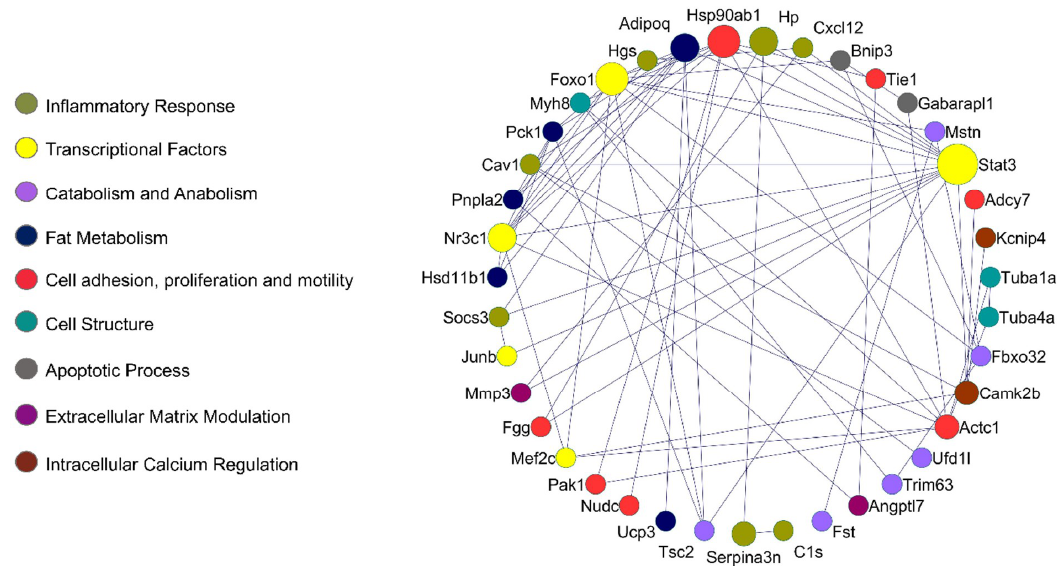
Figure 3. Protein–protein interaction (PPI) network in muscle wasting in cancer cachexia. Lines highlight PPI, with Stat3, Foxo1, Camk2b, Adipoq, Nr3c1, and Actc1 presenting the highest number of interactions. Colors highlight biological processes or molecular function of the circle network components. The larger the circle, the higher the number of interactions identified. STRING v10.5.1 was used to generate protein interactions, and the resulting network was visualized using Cytoscape